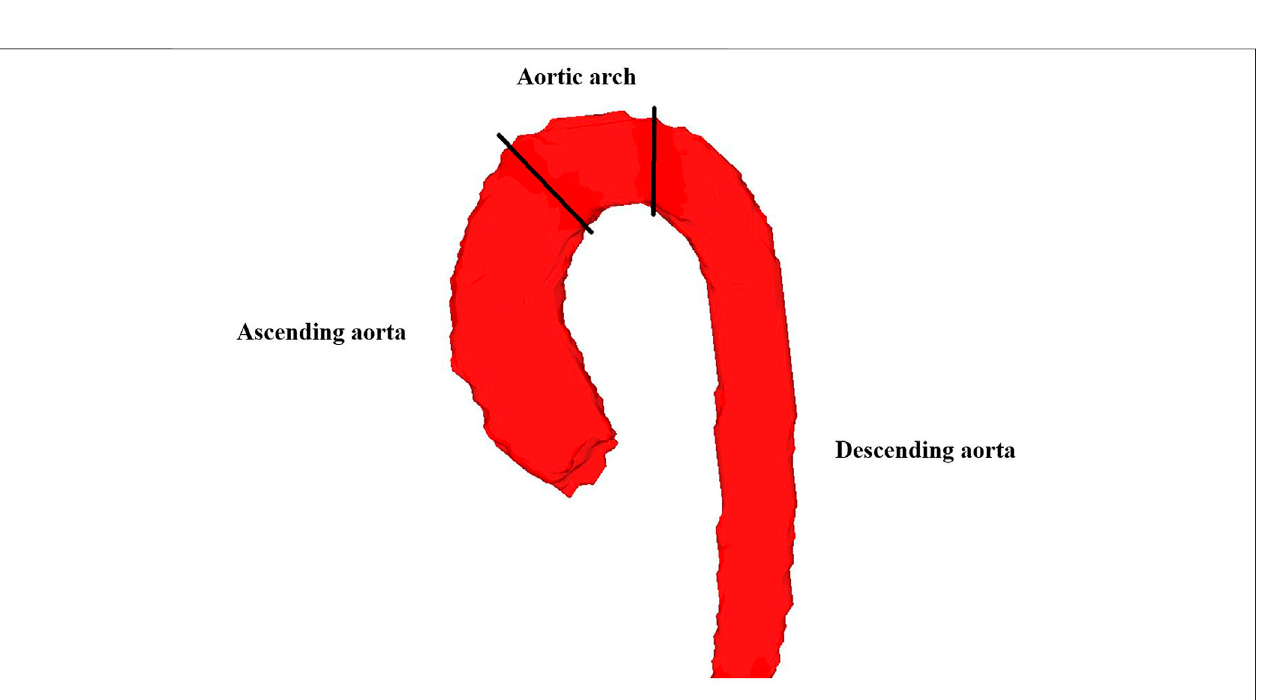
FIGURE 2 | Segmentation of the thoracic aorta in one of the healthy subjects. The whole thoracic aorta was divided into three regional volumes; ascending aorta, aortic arch and descending aorta. The boundaries between these regional volumes are illustrated with black lines.